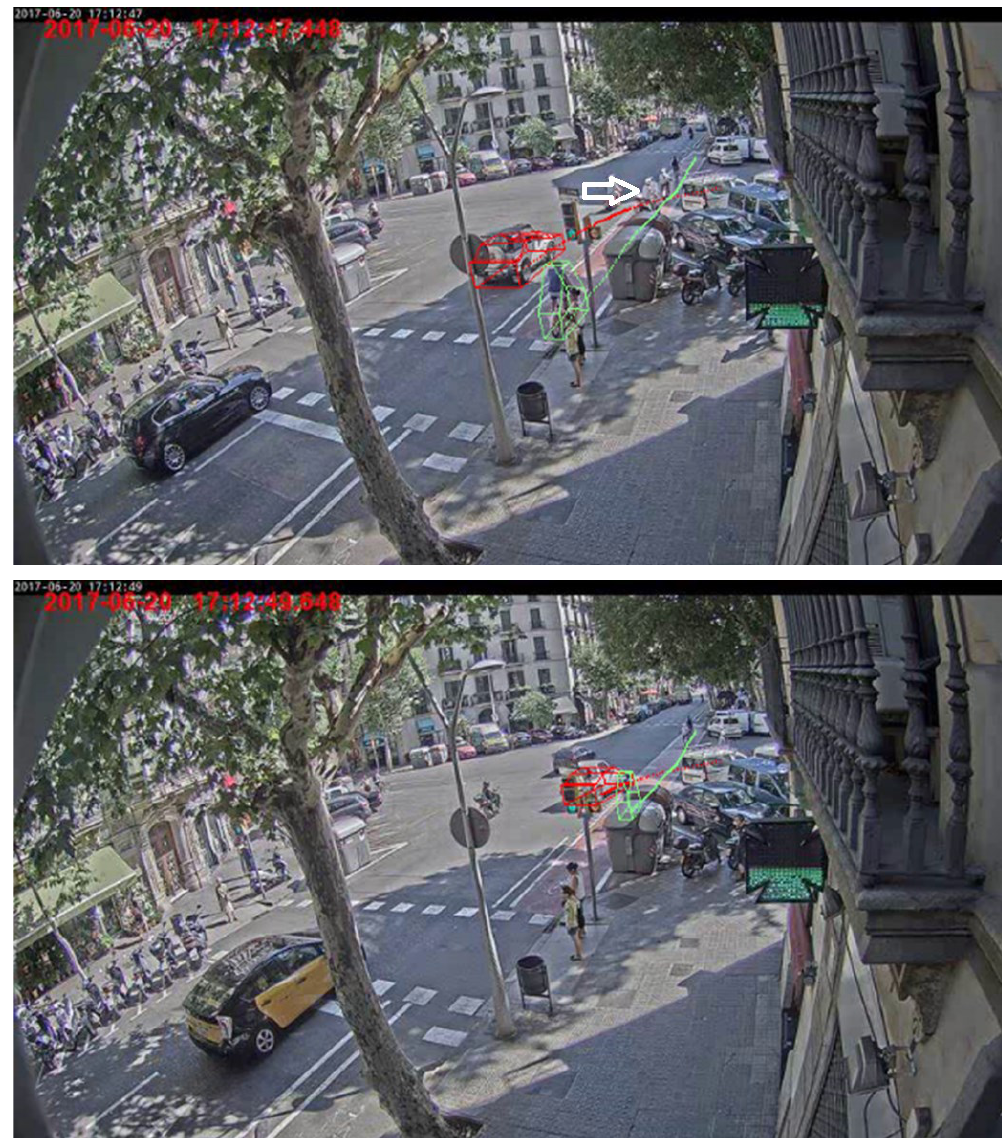
Figure 11 A secondary interaction in which the car (marked red) first brakes for one bicyclist (marked with an arrow) and then again brakes for the second bicyclist (marked